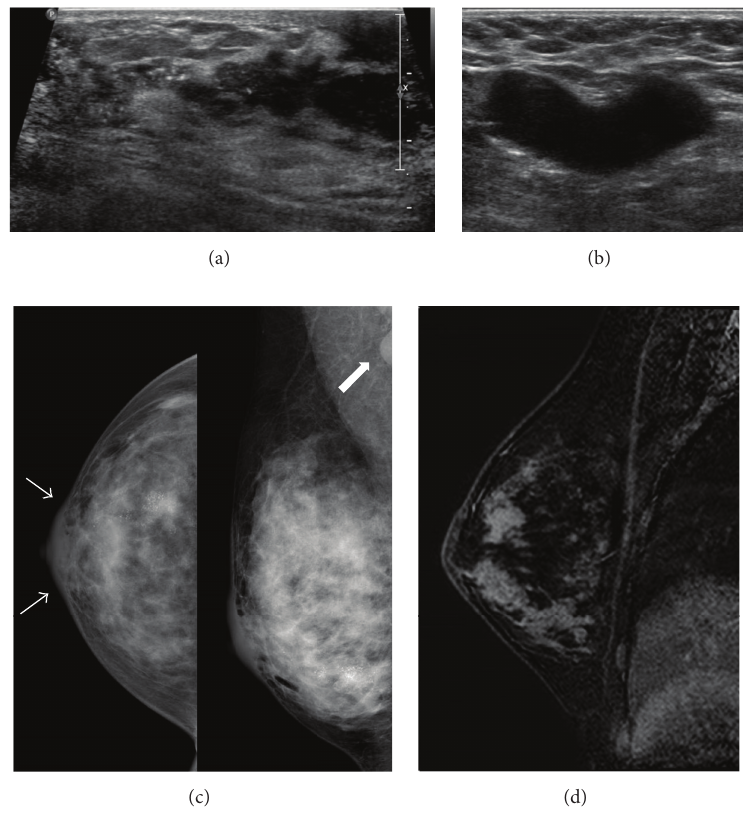
Figure 1: Ultrasonography shows an ill-defined hypoechoic mass with microcalcifications and irregular duct changes in the right breast. The mass with irregular duct changes extends to the subareolar area (a). Metastatic lymph node is seen in the ipsilateral axilla (b). Mammography shows fine pleomorphic microcalcifications with segmental distribution in the lower outer portion of the right breast. And mild skin thickening (arrows in c) and metastatic lymph node are also noted (c). Magnetic resonance imaging shows that lesion exhibits nonmass enhancement lesion with heterogeneous internal enhancement pattern and occupies most of the right breast, except the lower inner portion